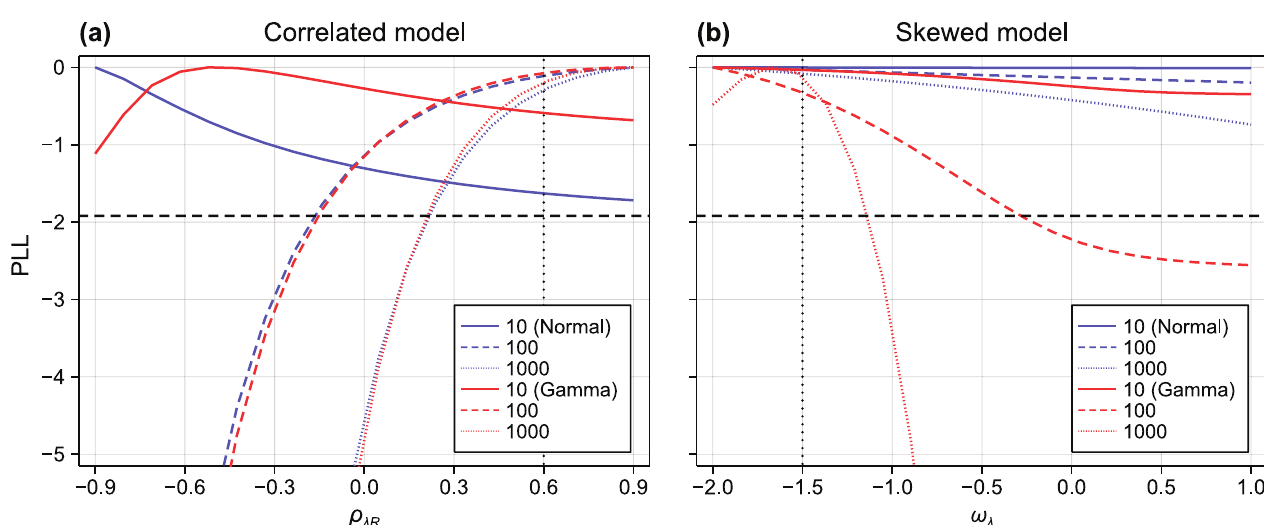
Fig 4. Profile likelihoods for an unknown correlation coefficient and growth rate distribution skewness. (A) We infer hyperparameters from synthetic data where the model parameters ( λ , R , r 0 , ε ) are multivariate normal as in Fig 3, but with single unknown correlation Cor( λ , R ) = ρ λ hyperparameters from synthetic data where the model parameters are independent as in Fig 3, but where λ has a skewed distribution with unknown skewness ω λ = − 1.5. Only (A) ρ λ R and (B) ω λ are profiled. In both cases, we produce results using synthetic data sets of size N = 10 (solid), N = 100 (dashed), and N = 1000 (dotted), where normal (blue) and gamma (red) surrogates are used (black horizontal